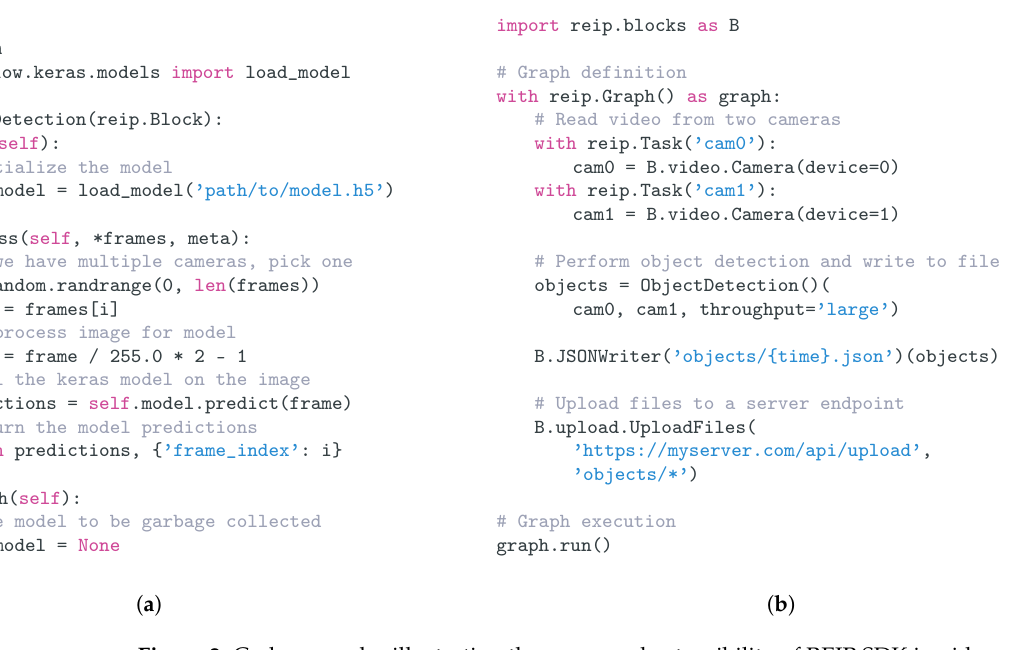
Figure 2. Code examples illustrating the usage and extensibility of REIP SDK in video capture and processing application. ( a ) Block implementation for a machine learning model. It consists of an init , process ( . . . ) and finish methods. The process method takes frames from multiple cameras and chooses one to perform object detection on it. ( b ) Graph definition showing object detection on a video stream with the detections saved in JSON files and uploaded to an API